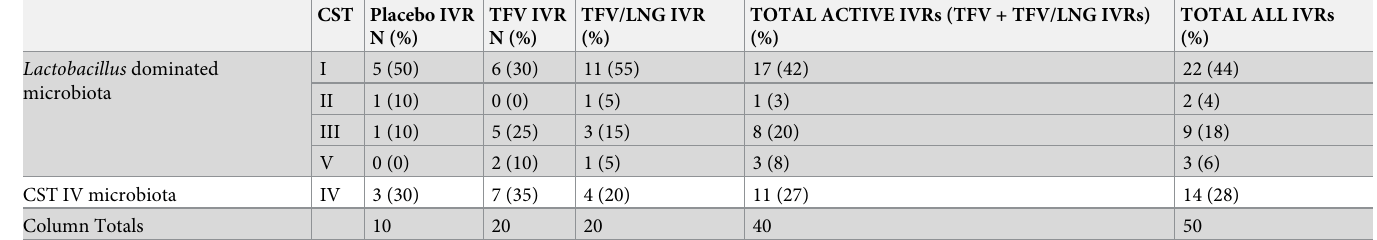
Table 2. Community state type (CST) frequencies at visit 7 for TFV, TFV/LNG and Placebo IVR users combining all Lactobacillus dominated CSTs (CST I, II, III and V), and CST IV.